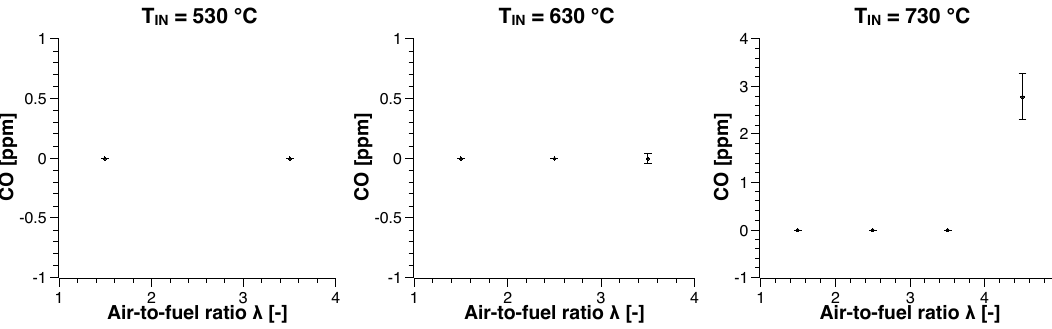
Figure 4. O 2 concentration (% vol) in the exhaust gases as a function of the air-to-fuel ratio λ for different values of the air inlet temperature.